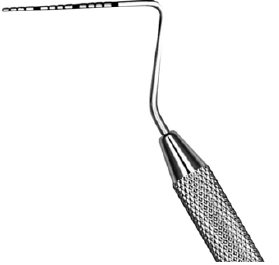
Figure 3. PCP15 periodontal probe.